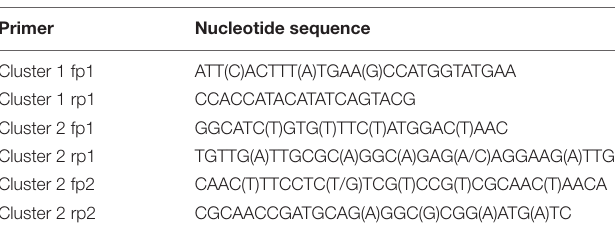
TABLE 1 | Primers used for detection of K-07020 and